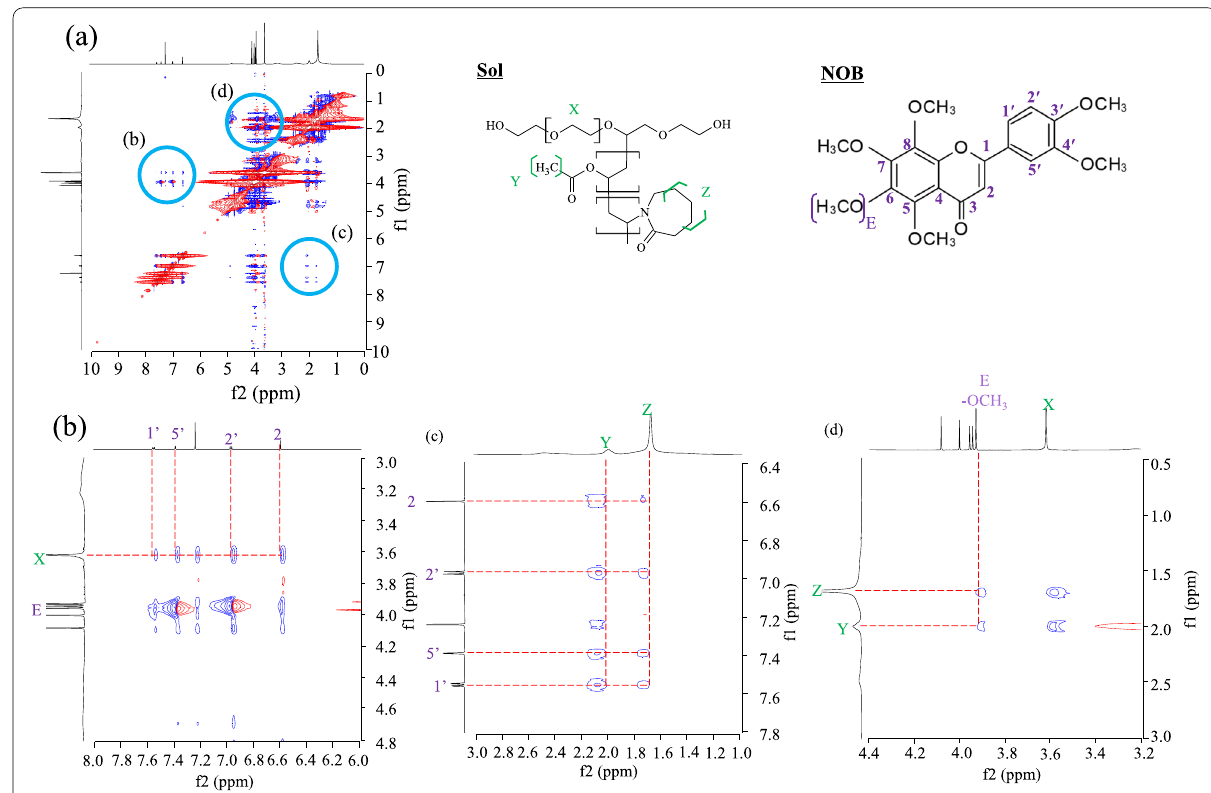
Fig. 5 1 H- 1 H ROESY NMR spectrum EVP (Sol/NOB 8/2) in CDCl 3 . a f1 is 0–10 ppm and f2 is 0–10 ppm; b f1 is 3.0–4.8 ppm and f2 is 6.0–8.0 ppm; c = f1 is 6.4–7.8 ppm and f2 is 1.0–3.0 ppm; d f1 is 0.5–3.0 ppm and f2 is 3.0–4.8